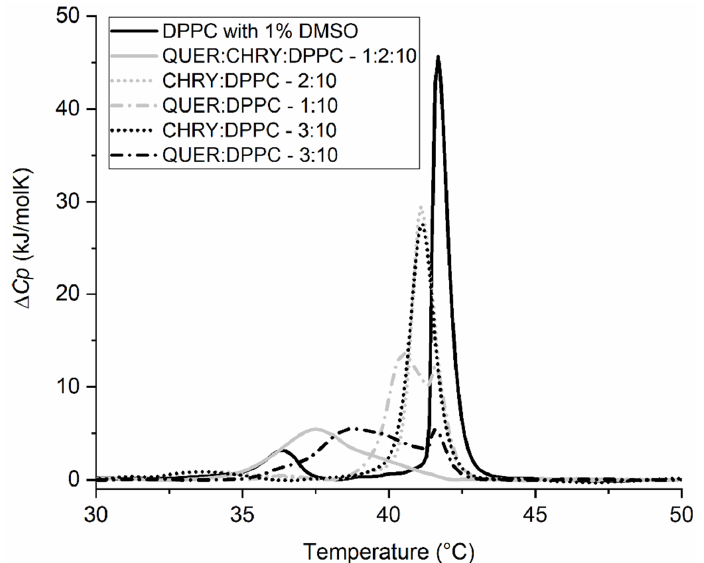
Figure 7. DSC thermograms of 1,2-dipalmitoyl- sn -glycero-3-phosphatidylcholine (DPPC) liposomes in 20 mM HEPES (pH = 7.0) buffer and 1% dimethyl sulfoxide (DMSO) (negative control), and in the presence of chrysin (CHRY), quercetin (QUER), or their mixture at different n compound(s) : n DPPC molar ratios. Δ C p is the change in heat capacity. Table 3. The thermodynamic profile of the 1,2-dipalmitoyl- sn -glycero-3-phosphocholine lipids